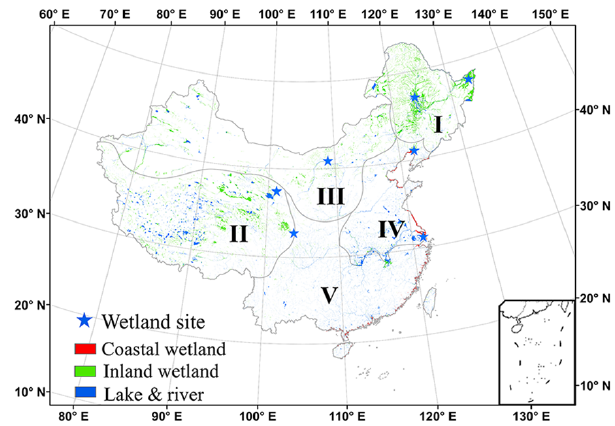
Figure 2. Wetland regions across China. The blue stars are the lo- cations of the wetland sites. The wetland distribution map is from the remote sensing data in